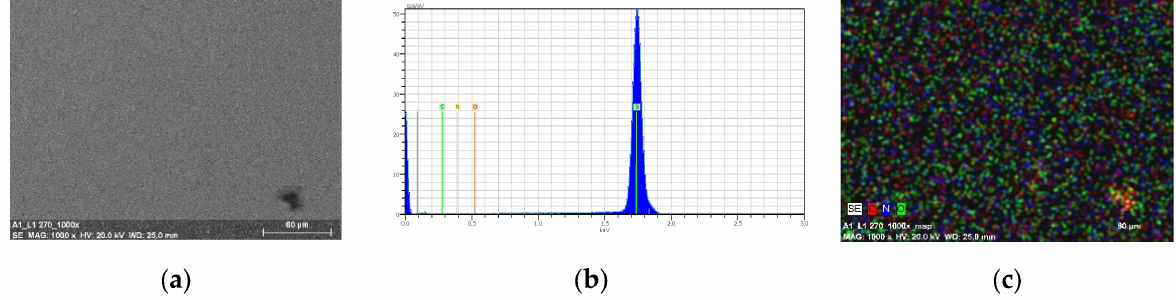
Figure 12. SEM of L1 /Si ( a ) L1 /Si; 3000 rpm 5s × 10 ( b ) EDS and ( c ) mapping of L1 /Si, 3000 rpm 5s × 10, scan size 1 µ m.